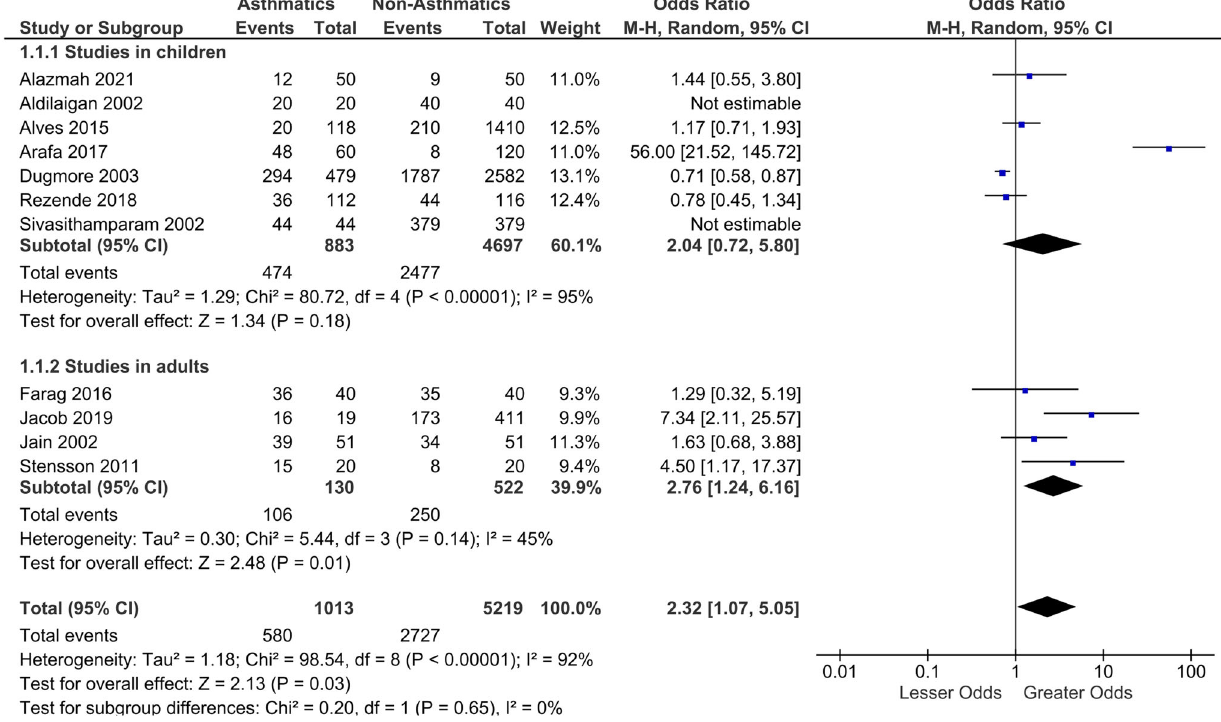
Fig. 3 Forest plot. Diagram after removing the study by Grugel et al.